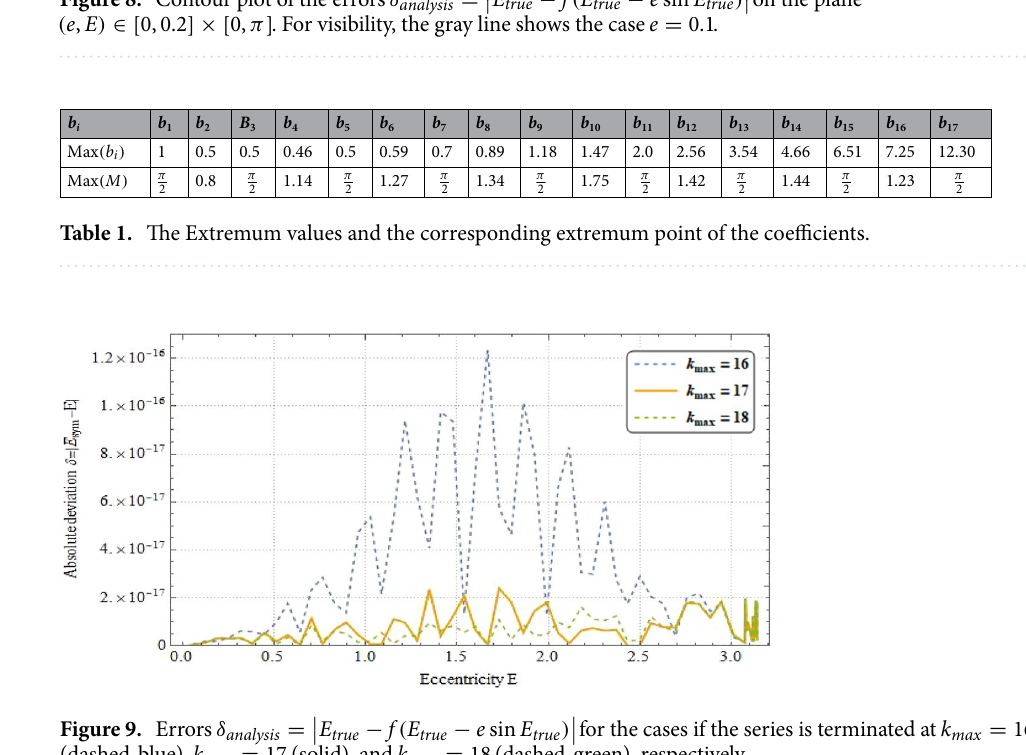
Figure 9. Errors δ analysis = (dashed-blue), k max = 17 (solid), and k max = 18 (dashed-green),